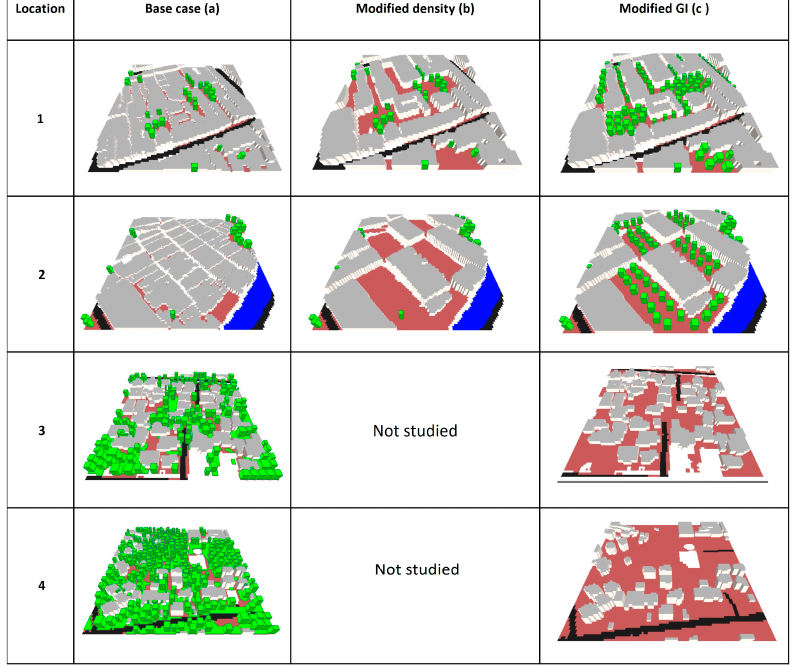
Figure 7. Three-dimensional view of simulation models. Note: ‘Modified GI’ cases for locations 3 and 4 consisted of the removal of all GI without changes to building volume (see descriptions of cases in Section 3.3).